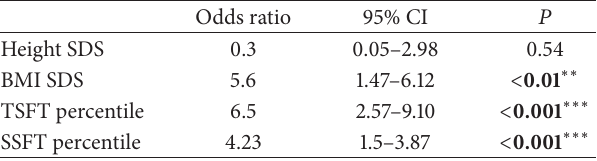
Table 4: Multivariate regression analysis to evaluate association of serum ghrelin with low anthropometric parameters among studied cases ( 𝑛 = 40